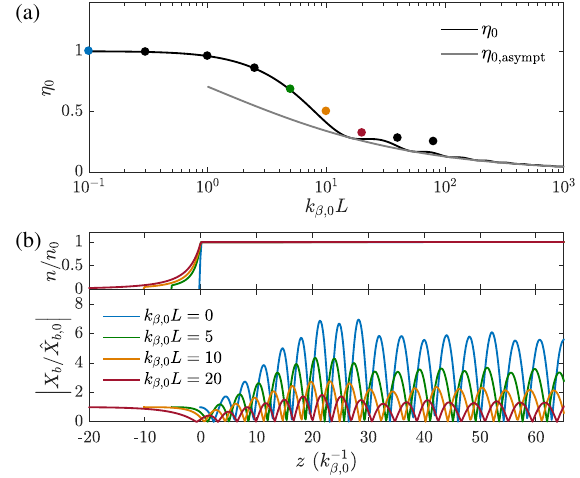
FIG. 6. Reduction of the hosing seeds in plasma density tapers with λ ¼ λ at the tail of the beam k p ξ ¼ 4 . 0 . (a) Relative hosing opt seed η 0 according to Eq. (29) (black), respective asymptotic solution η 0 ; (gray) and results from PIC simulations asympt (circles). (b) Density profiles for different taper lengths (top) and respective beam centroid amplitudes from PIC simulations (bottom) for k β ; 0 L ¼ 0 (blue), k β ; 0 L ¼ 5 (green), k β ; 0 L ¼ 10 (orange), and k β ; 0 L ¼ 20